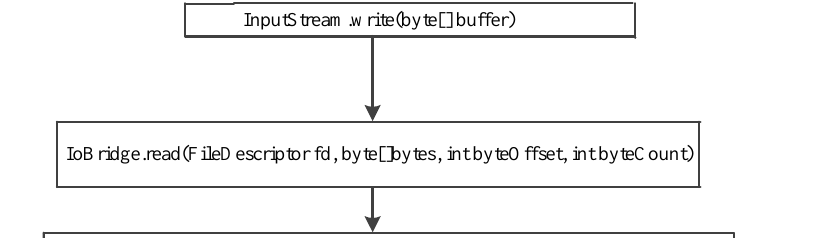
Figure 11. Taint operation for the “recvfrom” method.